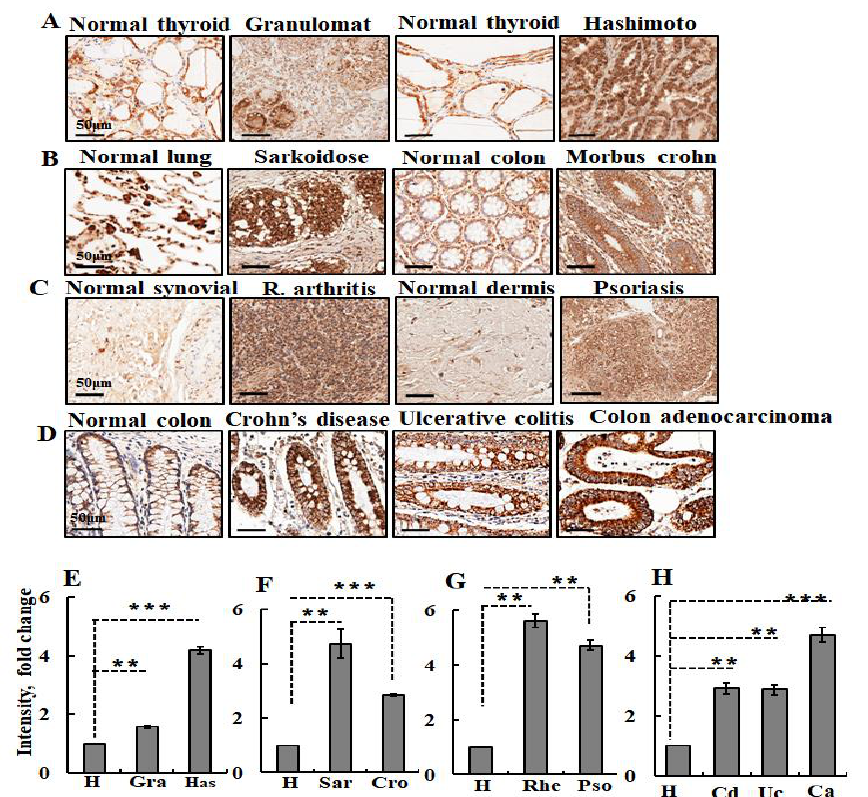
Figure 5. VDAC1 is overexpressed in tissue samples from autoimmune disease patients. ( A – D ) immunohistochemistry staining (IHC) of VDAC1 was performed on tissue microarray slides obtained from Provitro AG (Charité Campus Mitte 10,117 Berlin, Germany) ( A – C ) and US Biomax, Inc. (MD USA) ( D ). The array contains tissue sections from healthy (normal thyroid, lung, colon, synovial, dermis samples), ( A ) granulomat (Gra), Hashimoto thyroiditis (Thyroid, Has), ( B ) sarcoidosis (lung, Sar), Morbus Crohn (Sigma), ( C ) rheumatoid arthritis (Synovial, Rhe), psoriasis (Pso), ( D ) Crohn’s disease (Cd), ulcerative colitis (Uc), colon adenocarcinoma (Ca). ( E – H ) Quantitative analysis of